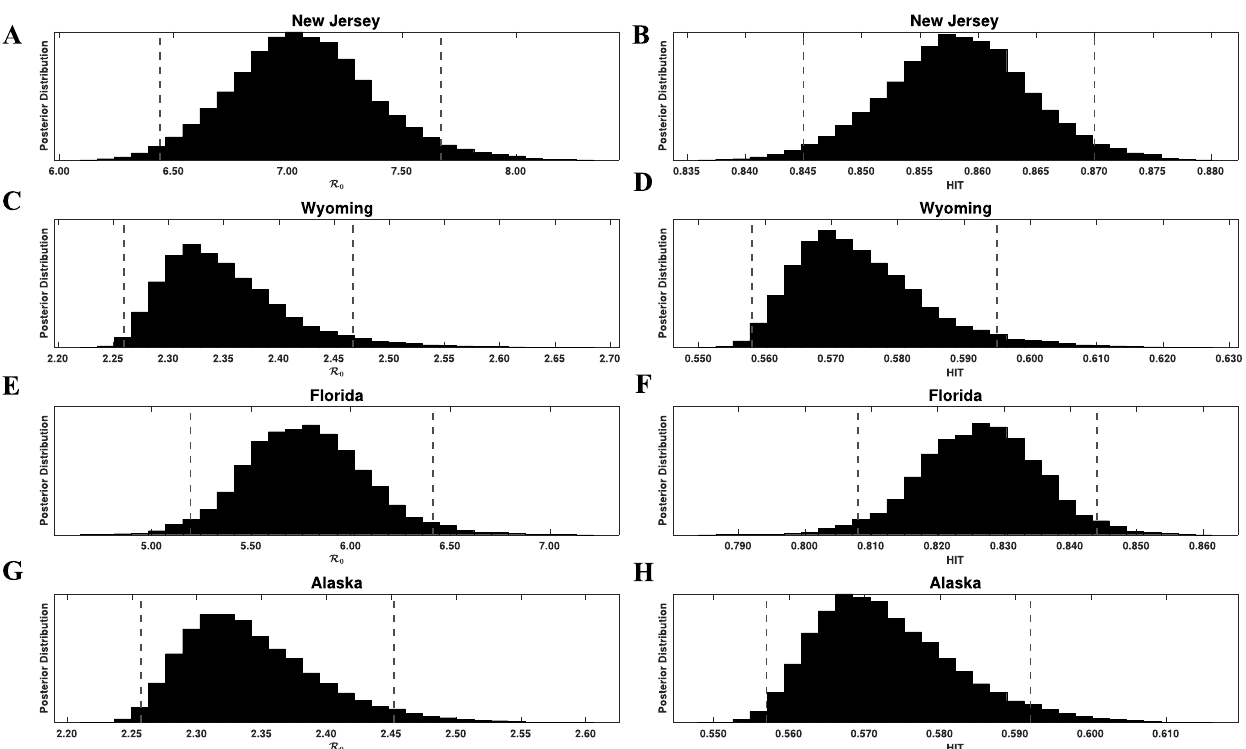
Figure 2. Marginal posterior distributions of ℛ 0 (left panels) and HIT (right panels) for ancestral strains of SARS-CoV-2 in four US states: ( A , B ) New Jersey, ( C , D ) Wyoming, ( E , F ) Florida, and ( G , H ) Alaska. Inferences are based on daily reports of new cases from 21 January to 21 June 2020. Each ℛ 0 posterior was obtained from the corresponding marginal posterior for β and Equation (1). Each HIT posterior was obtained from the relation HIT = 1 − 1/ℛ 0 and the corresponding marginal posterior for ℛ 0 . The 95% credible intervals for ℛ 0 are as follows: (6.44, 7.67) for New Jersey, (2.26, 2.47) for Wyoming, (5.20, 6.41) for Florida, and (2.26, 2.45) for Alaska. The 95% credible intervals for the HIT estimates are as follows: (0.84, 0.87) for New Jersey, (0.56, 0.59) for Wyoming, (0.81, 0.84) for Florida, and (0.56, 0.59) for Alaska. For each panel, the endpoints of the corresponding credible interval are indicated with vertical broken lines.